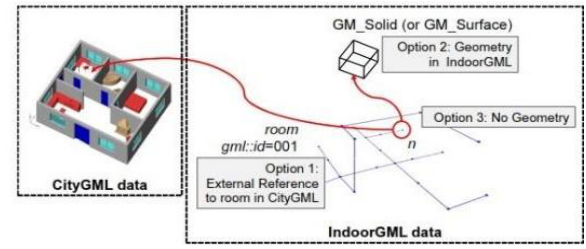
Figure 4. Geometry of cell of IndoorGML (Kim et al., 2014).